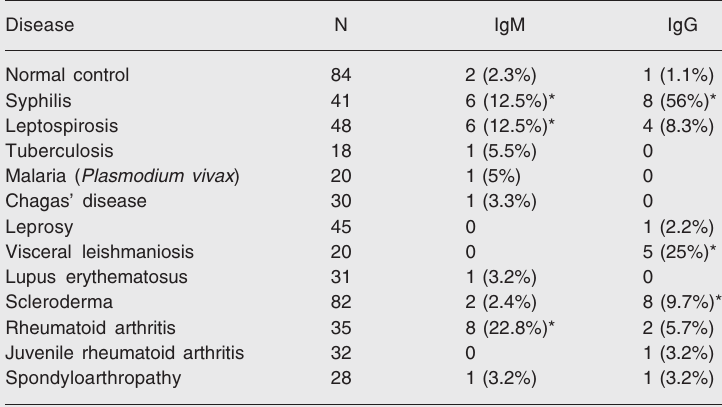
Table 1. Serology for Borrelia burgdorferi (ELISA) in infectious and rheumatic diseases in Brazilian